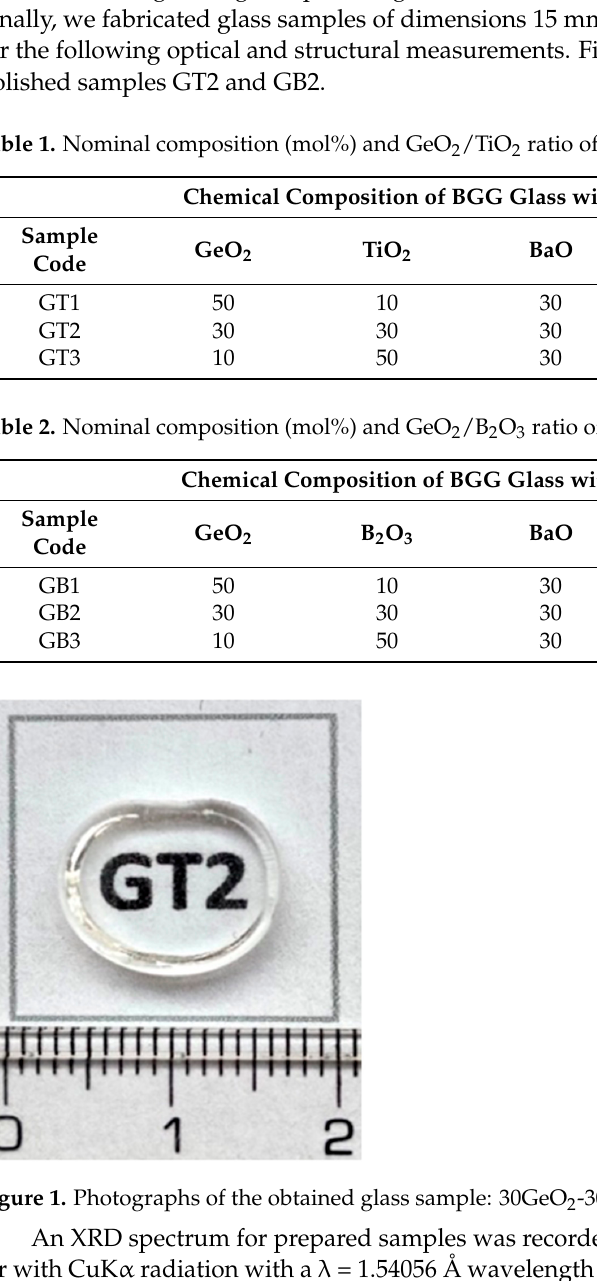
Figure 2. Photographs of the obtained glass sample: 30GeO 2 ‐ 30B 2 O 3 ‐ 30BaO ‐ 10Ga 2 O 3 (GB2). Table 1. Nominal composition (mol%) and GeO 2 /TiO 2 ratio of glass samples. Chemical Composition of BGG Glass with TiO 2 (mol%) Sample Code